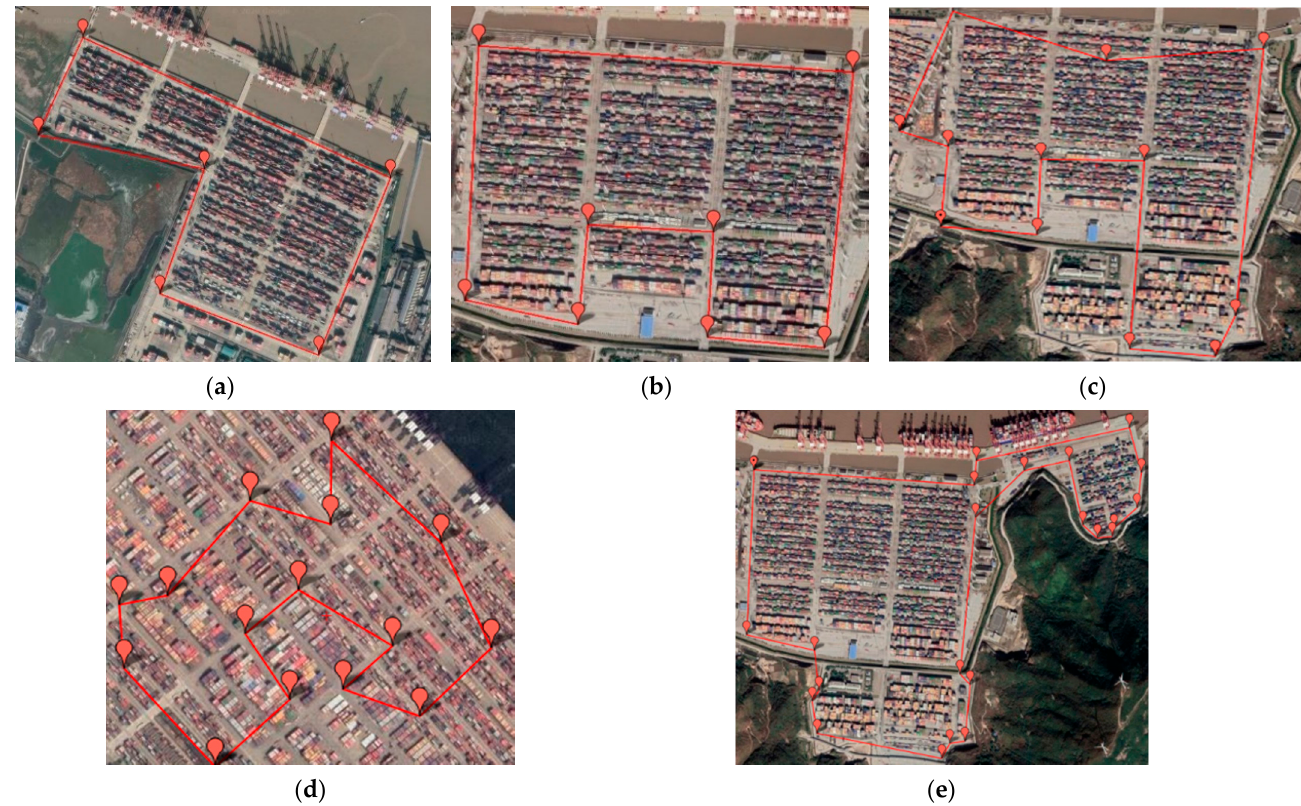
Figure 25. Five different shapes of detection areas. ( a ) Area A; ( b ) area B; ( c ) area C; ( d ) area D; ( e ) area